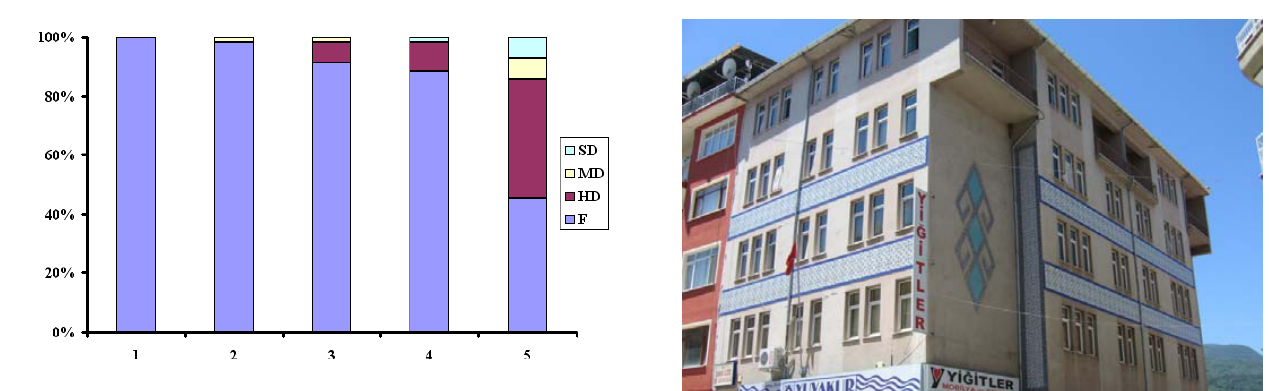
Fig. 16. Column cross-sectional damage.